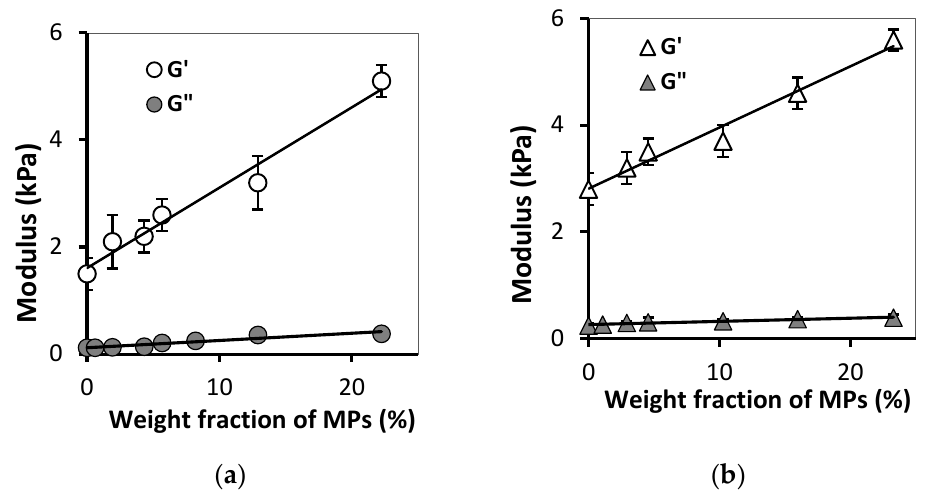
Figure 6. Dependences of storage modulus (G') and loss modulus (G'') on the MPs concentration for samples PAAm/Xanthan ( a ) and PAAm/Guar ( b ). Vertical bars reflect the confidence interval with p = 0.01 ( n = 5). Equations of linear regression are: ( a ) y = 0.15x + 1.60 (R 2 = 0.973) for G' and y = 0.01x + 0.11 (R 2 = 0.85) for G''; ( b ) y = 0.11x + 2.81 (R 2 = 0.98) for G' and y = 0.01x + 0.26 (R 2 = 0.95) for G''.